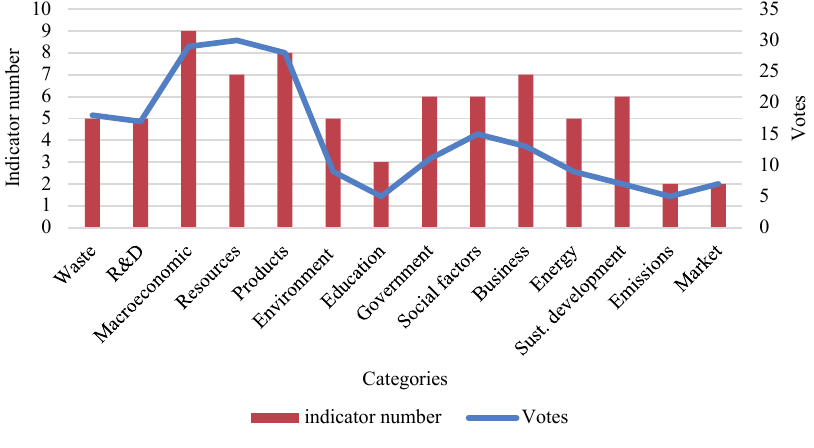
Fig. 1. Number of indicator and total votes count for each